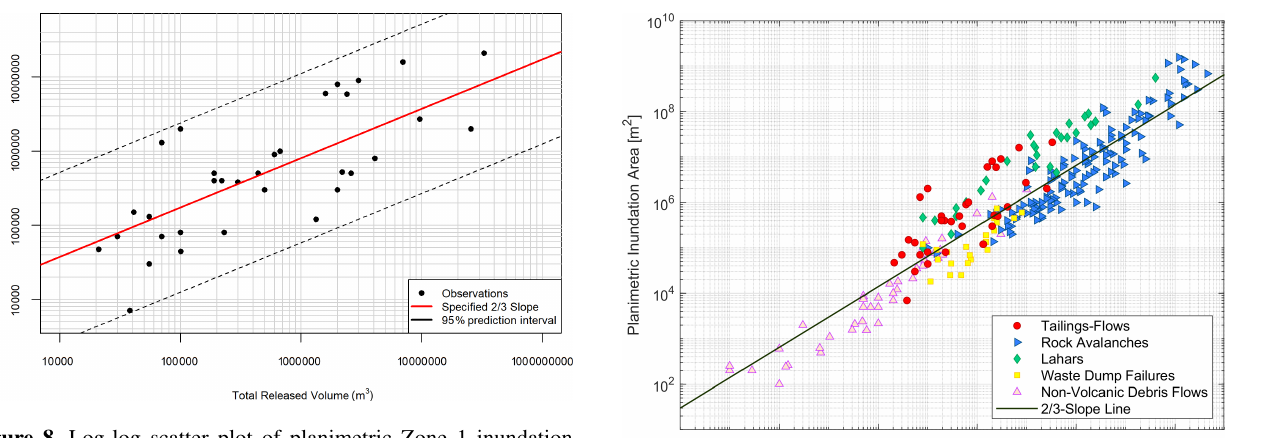
Figure 8. Log-log scatter plot of planimetric Zone 1 inundation area versus total released volume for the 33 tailings-flow cases. The specified two-thirds slope regression line (in red) is fitted to the data, and the 95% prediction intervals (dashed lines) of this regression line are also plotted.